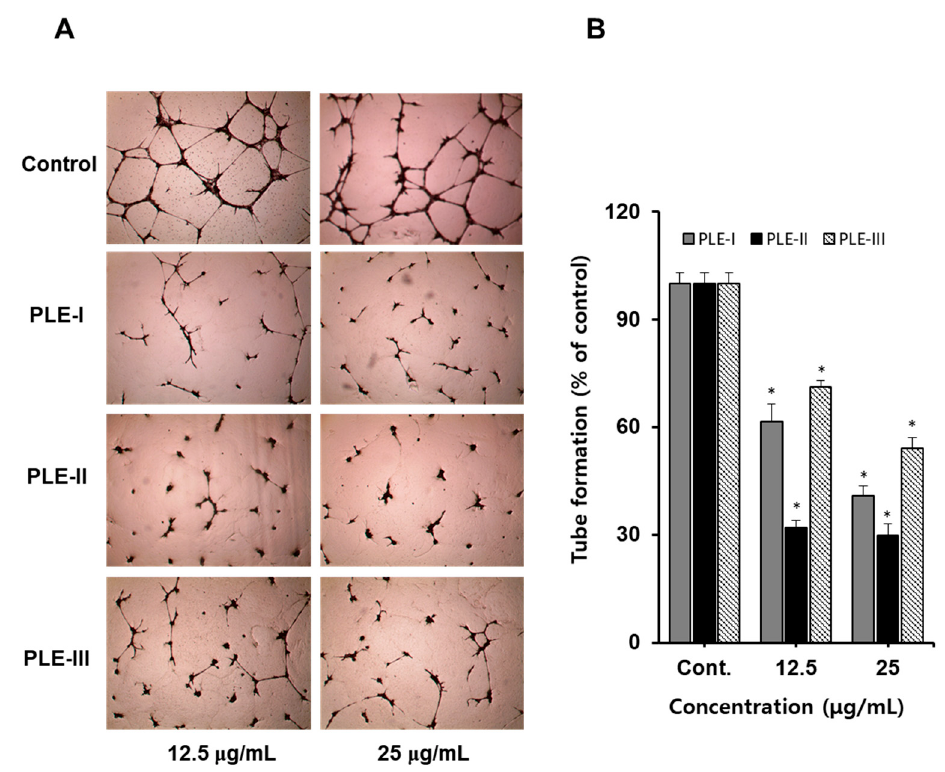
Figure 3. The effect of PLE-I–III on a tubule formation in HUVECs. ( A ) Cells were incubated in PLE-I–III at the indicated concentrations (12.5 or 25 μ g/mL) for 24 h. Representative images were obtained using light microscopy after staining HUVECs with hematoxylin. ( B ) The relative length of the tubes was measured using ImageJ software. * p < 0.05 vs. the control group.